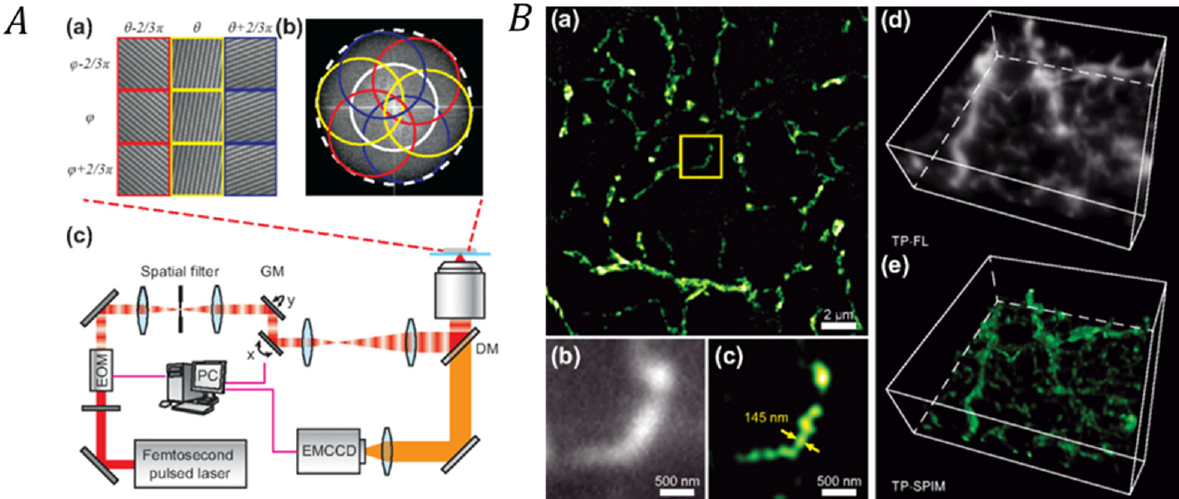
Figure 8. Correlative 2P-SIM for increased imaging depth. ( A ) Schematic diagram of the optical methodology of 2P-SIM [93]. ( a ) Image of fluorescein solution obtained using scanning patterned illumination. ( b ) Results of Fourier transformation of the images in ( a ). ( c ) Schematic of the 2P-SIM experimental setup. ( B ) 2P-SIM for thick sample imaging. ( a ) Two-dimensional 2P-SIM reconstruction image of hamster retinal ganglion cell dendrites at a depth of 100 µ m from the vitreal surface. ( b ) 2P and ( c ) 2P-SIM expanded views of the area outlined in yellow in ( a ). ( d ) 2P and ( e ) 2P-SIM volume renderings created from a total of 16 slices (images) collected at 1 µ m depth intervals. Copyright 2015 Physical Review E.